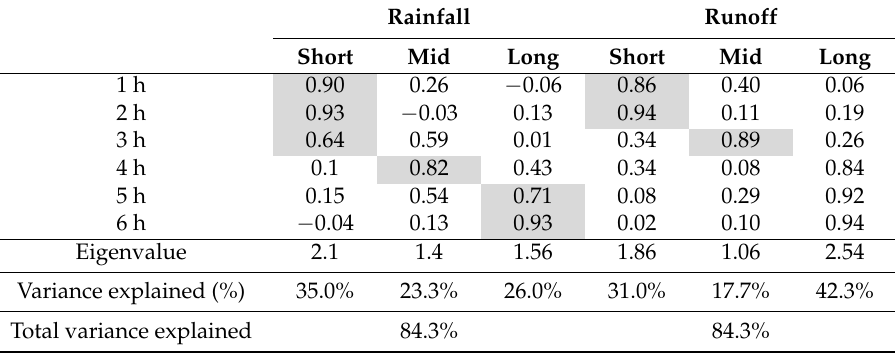
Table 4. Factor analysis results for (left column) rainfall and (right column) runoff. The shading indicates the statistically significant factors with high factor loading